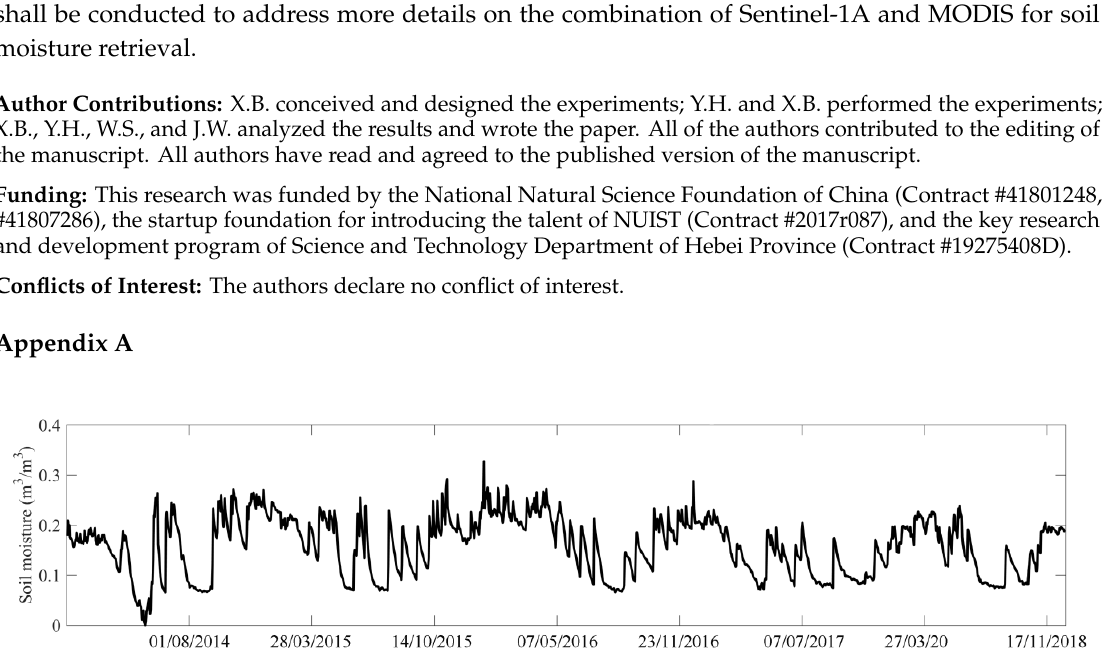
Figure A1. Time series of the daily average soil moisture from 1 January 2014 to 28 December 2018.